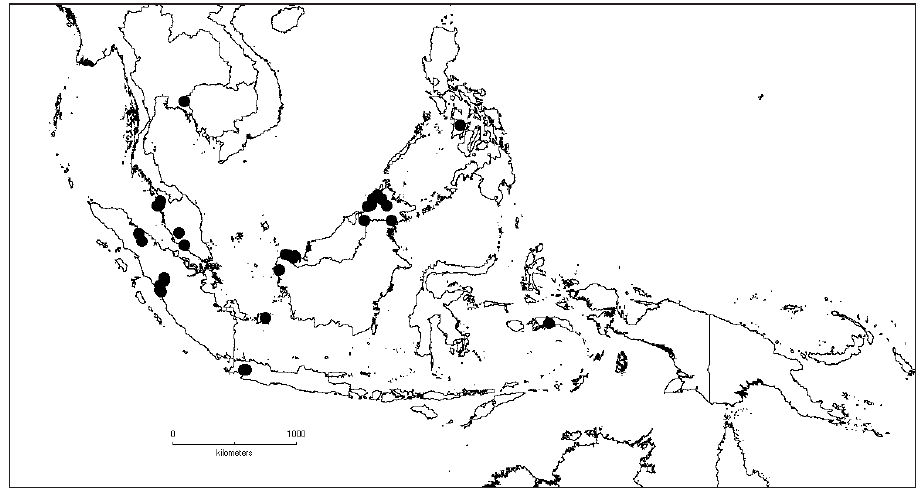
Map 7. Distribution of D. bracteata ( ●